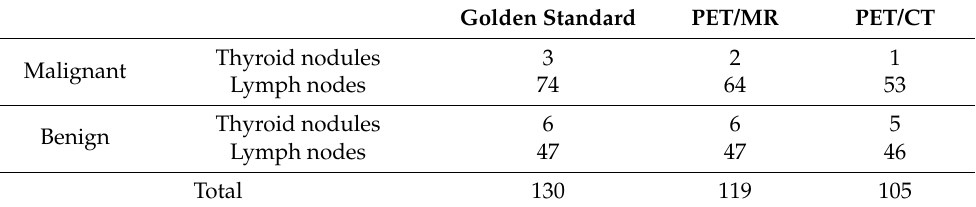
Table 2. Number of thyroid nodules and lymph nodes detected by 18 F-FDG PET/MR and PET/CT. Golden Standard PET/MR PET/CT